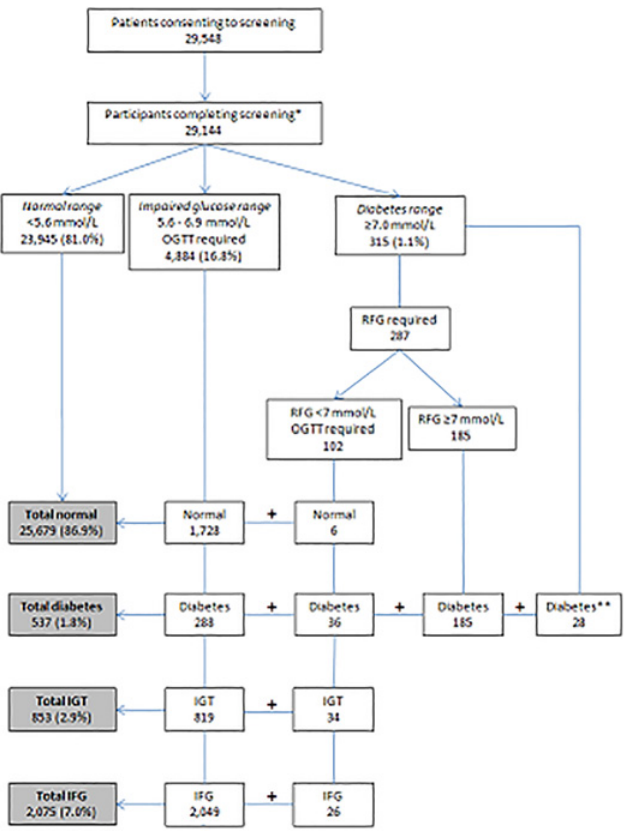
Fig 1. Results of DMVhi screening for undiagnosed type 2 diabetes, impaired fasting glucose and impaired glucose tolerance (March 2009-December 2012). RFG = repeat fasting glucose, IGT = impaired glucose tolerance, IFG = impaired fasting glucose, OGTT = oral glucose tolerance test. * Participants were not deemed to have completed screening if they did not return for required OGTT/RFG (n = 322) or did not provide a venous fasting sample (n = 82). ** Diagnosed with diabetes on fasting blood glucose ( (cid:1) 7.0 mmol/ L) and symptoms of diabetes.